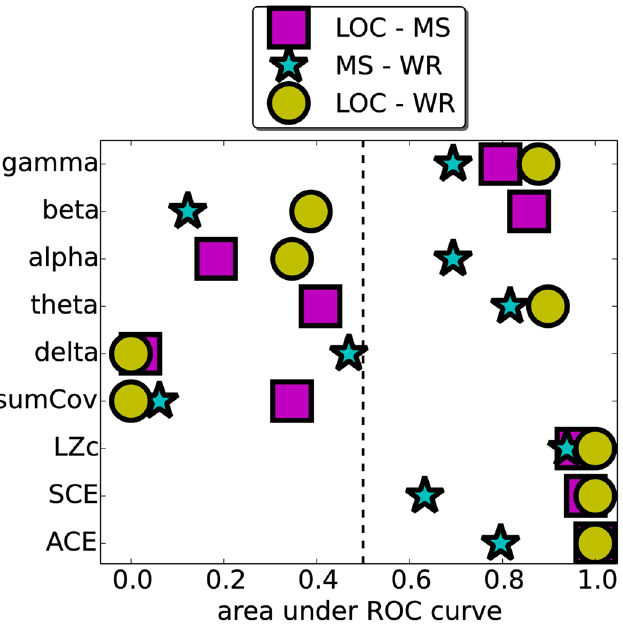
Fig 8. Discriminative power across subjects of nine measures, as measured by area under the ROC curve (AROC). Each symbol represents a state pair as indicated. The AROC is computed from the mean scores for the 7 subjects, obtained from the broadband signal from 25 electrodes from the whole cortex. The closer the AROC is to 0 or 1, the better the measure is at discriminating the given state-pair, close to 1 signifying that the measure tends to be greater for the more conscious state and close to 0 signifying that the measure tends to be greater for the less conscious state. When the AROC is 0.5 there is no discriminative power; hit rate equals false alarm rate for all classification thresholds. LZc, ACE and SCE have nearly maximal discriminative power for state pairs LOC/MS and LOC/WR. The measure sumCov fails to discriminate LOC/MS yet has strong (inverse) discriminative power for LOC/WR and MS/WR. Normalized delta band power discriminates LOC/WR and LOC/MS strongly yet MS/WR